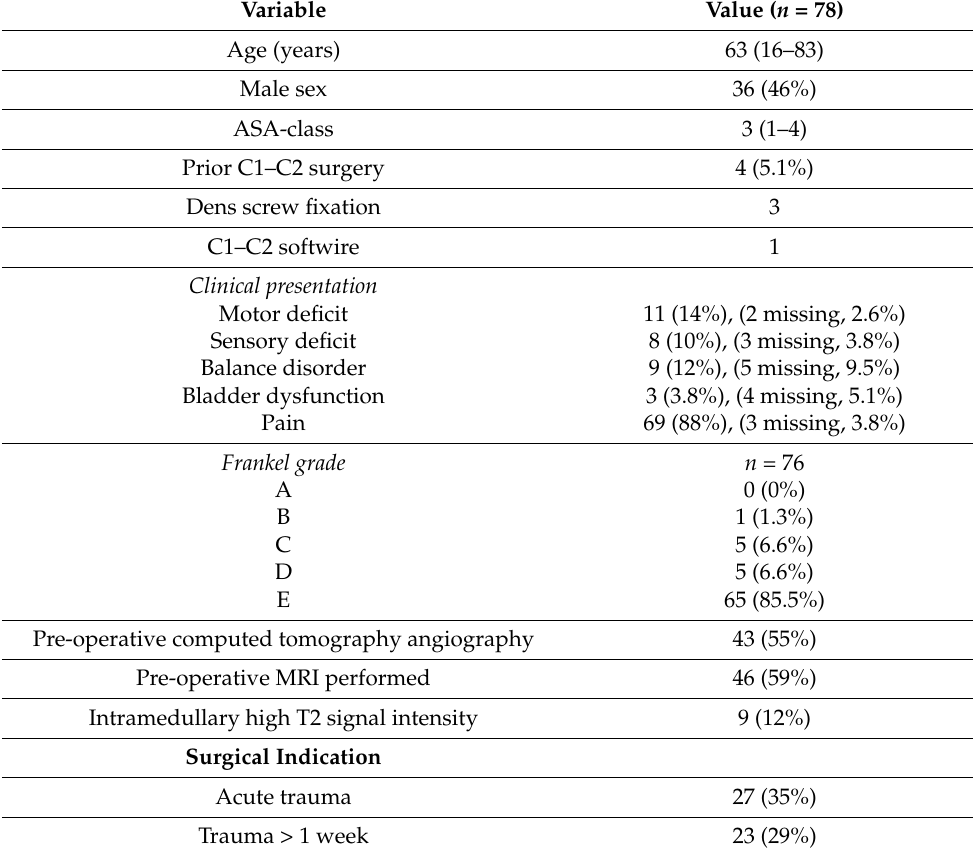
Table 1. Baseline